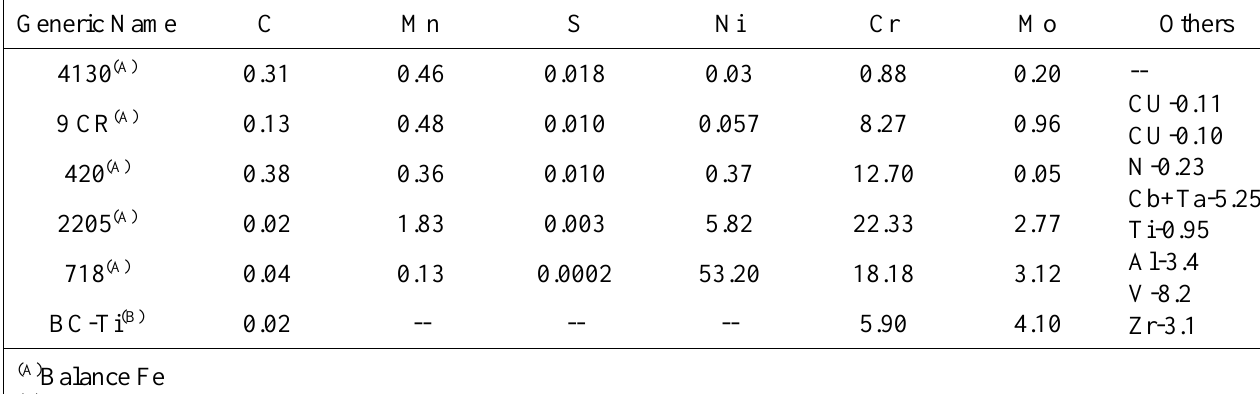
Table 2—The representative material of tubulars that fracturing fluids pass